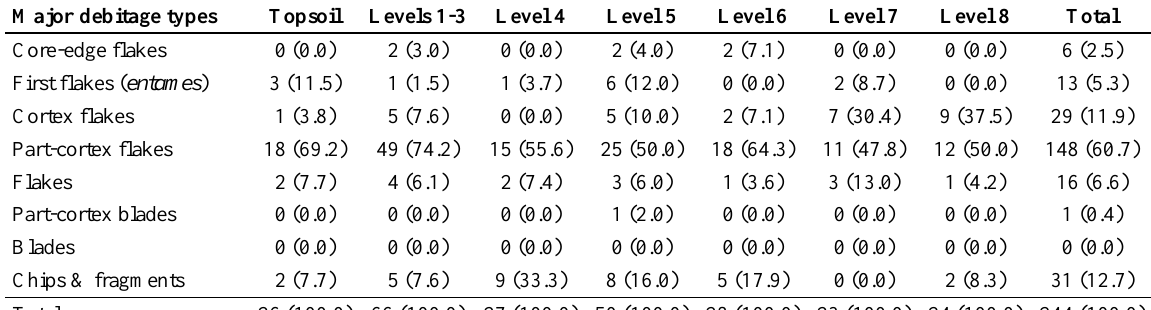
Figure 5. Changes of core types for Tell Ghanem al-Ali by phase. Table 3. Debitage from Square 2 of Tell Ghanem al-Ali.